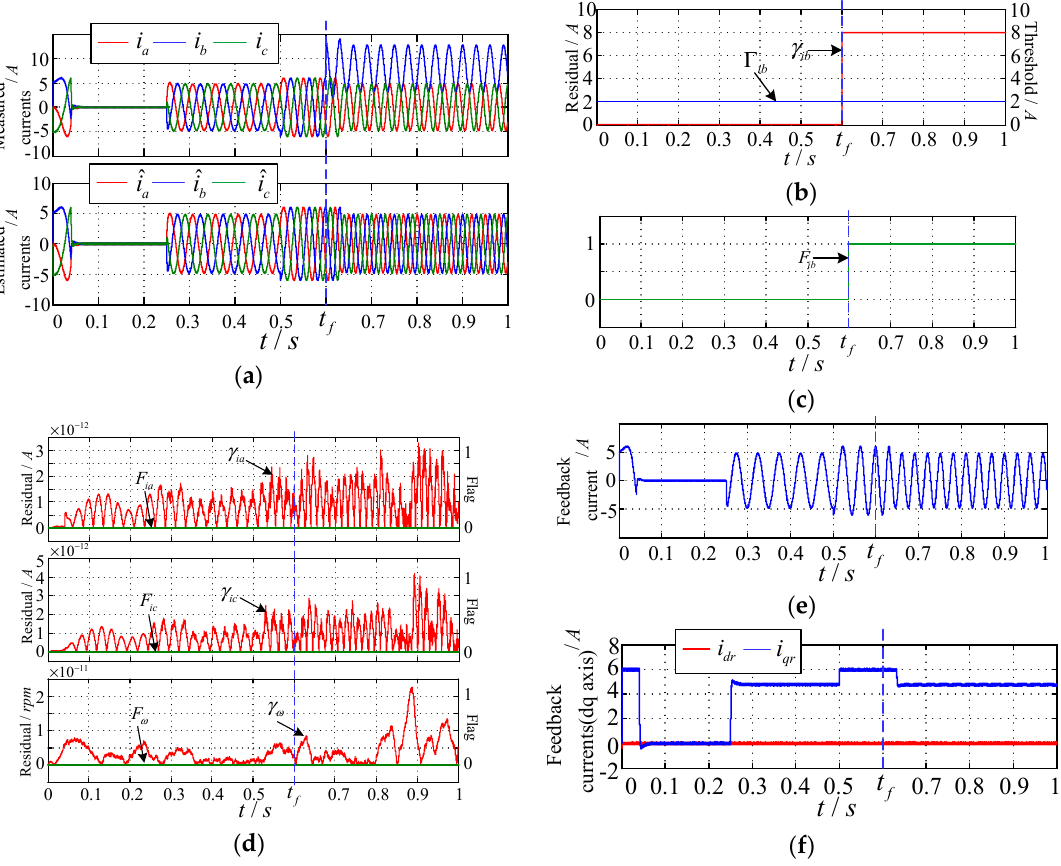
Figure 7. The system simulation waveforms in the case of constant deviation fault. ( a ) The measured signal i abc and estimated signal ˆ i abc of the three-phase stator current; ( b ) b -phase current residual γ ib and threshold Γ ib ; ( c ) The fault flag F ib of b -phase current sensor; ( d ) a -phase and c -phase current and speed residuals and fault flags; ( e ) b -phase closed-loop feedback current i br ; ( f ) Closed-loop feedback current i dqr in the dq coordinate system.